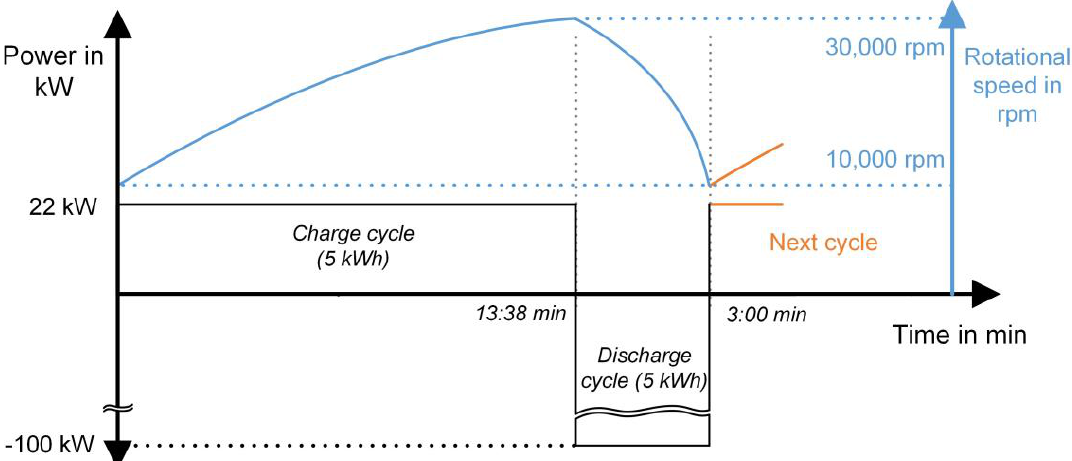
Figure 4. FESS load cycle underlying the presented bearing design.